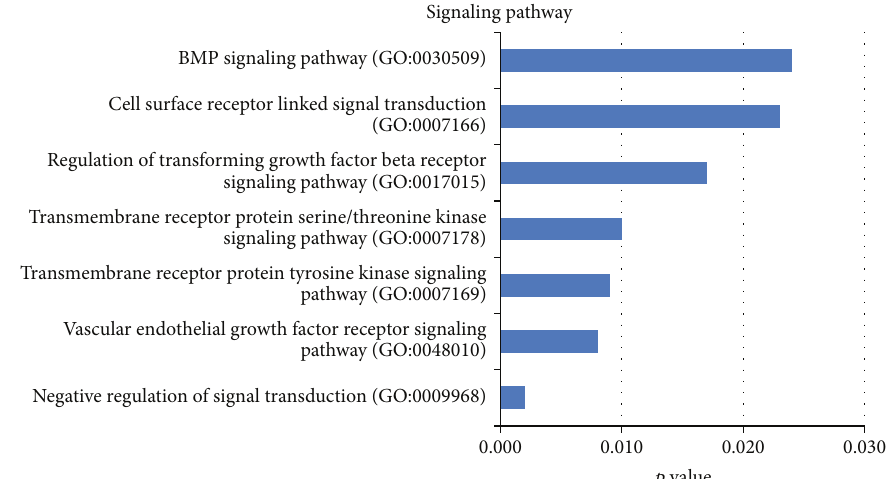
Figure 3: Functional annotations. 7 GO classification terms for biological processes in the group; signaling pathways in cluster 13 depending on the 𝑝 value ( 𝑝 < 0.04 ).